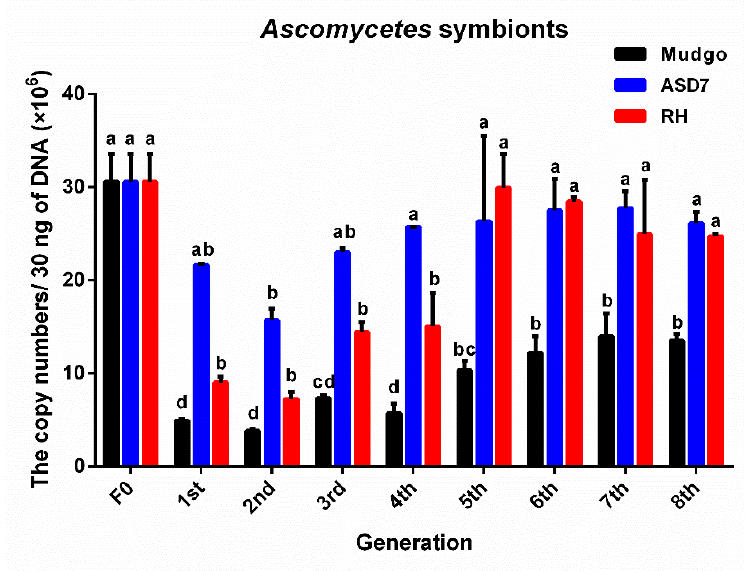
Figure 4. The copy number (×10 6 ) of Ascomycetes symbionts of BPH cultivated on three BPH-resistant rice varieties. The F0 generation is BPH raised on TN1 rice. There were significant differences between different lowercase letters ( p ≤ 0.01, one-factor ANOVA, and Tukey’s multiple comparisons).